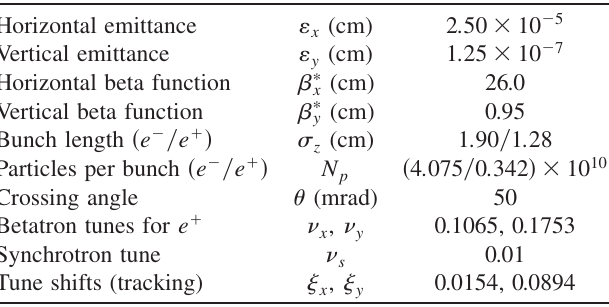
TABLE I. DA(cid:1)NE parameters in the ‘‘weak-strong’’ experi-